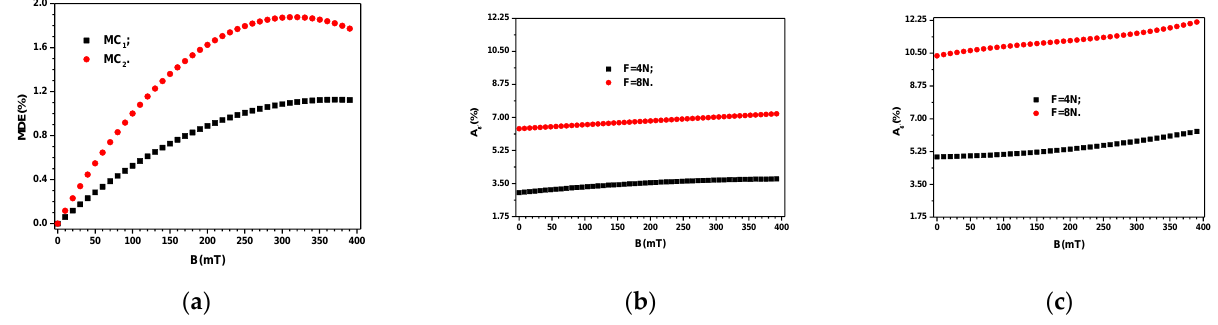
Figure 10. ( a ) Relative apparent MDE for MC 1 and MC 2 when F (cid:54) = 0 N. ( b ) The relative contribution A ε (cid:48) for MC 1 . ( c ) The relative contribution A ε (cid:48) for MC 2 .